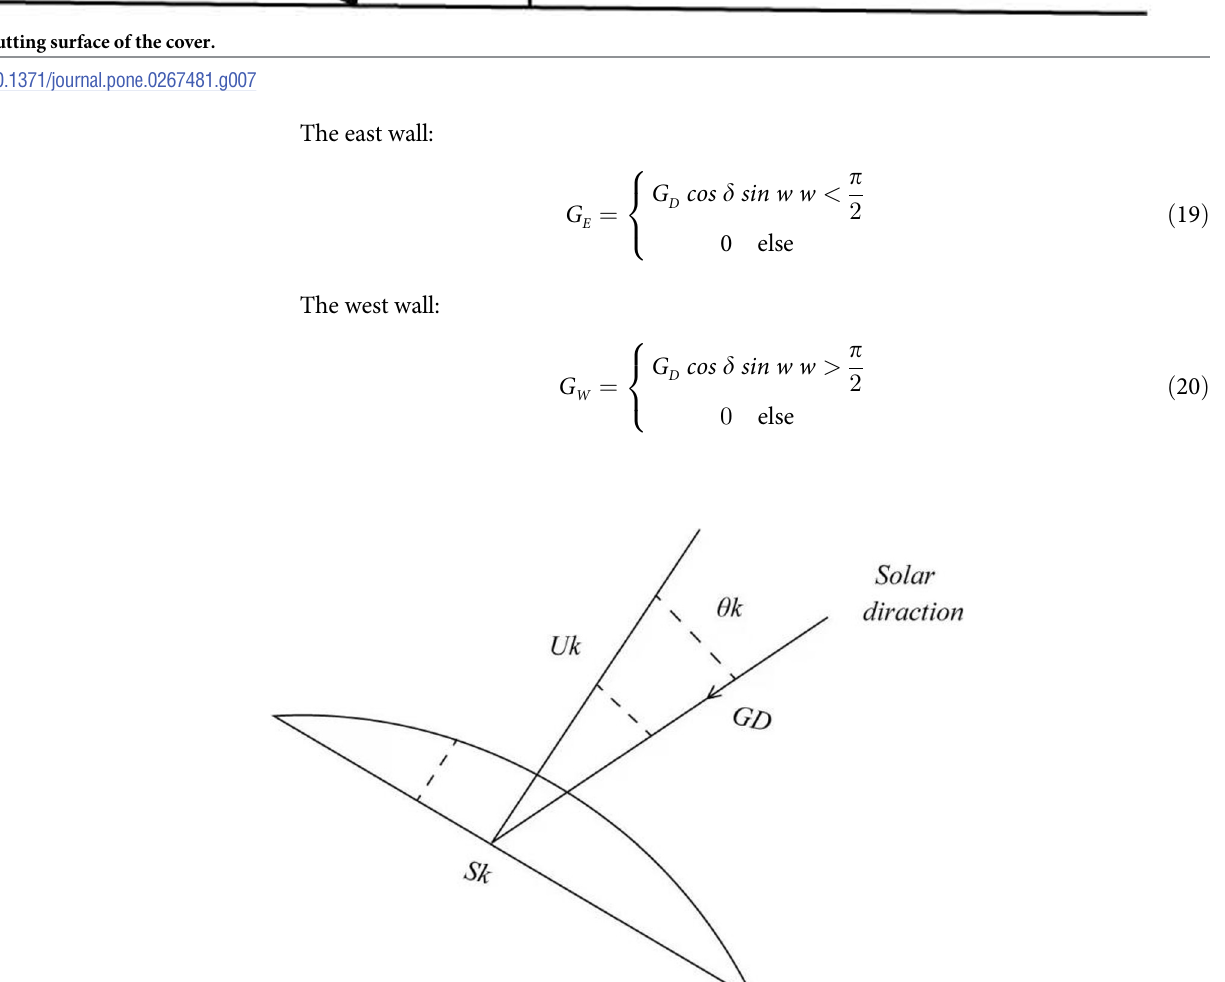
Fig 7. Planar cutting surface of the cover.